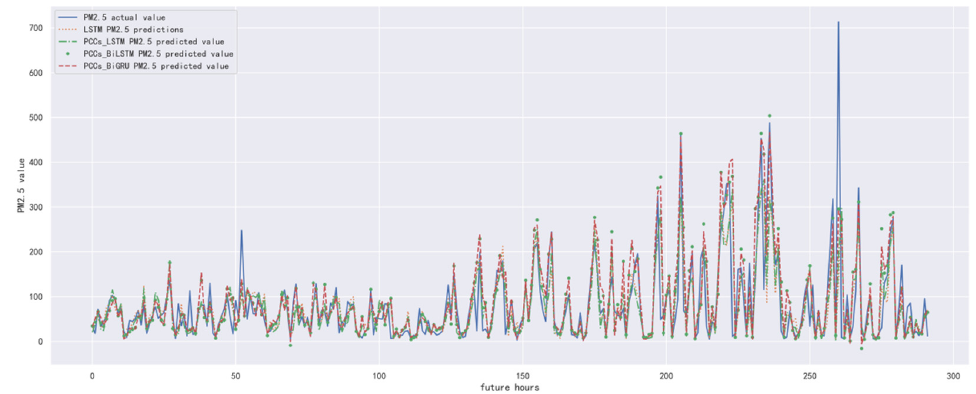
Figure 10. The schematic diagram of prediction results of PM 2.5 concentration in the next one hour.